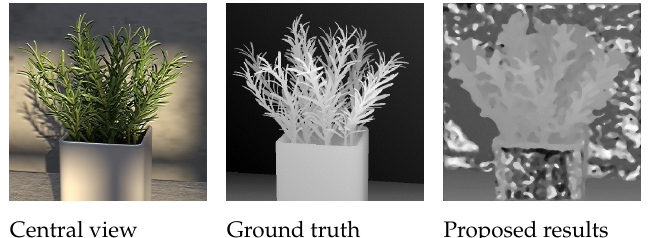
Figure 16. Misdetection of textureless regions in Rosemary